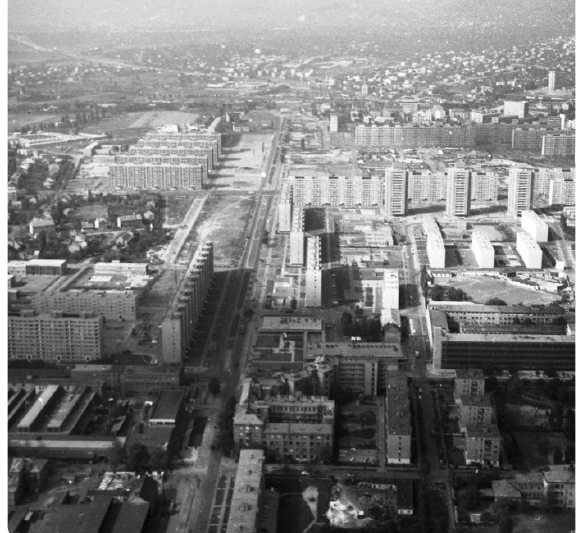
Figure 2. Kelenföld LHE seen from Est,